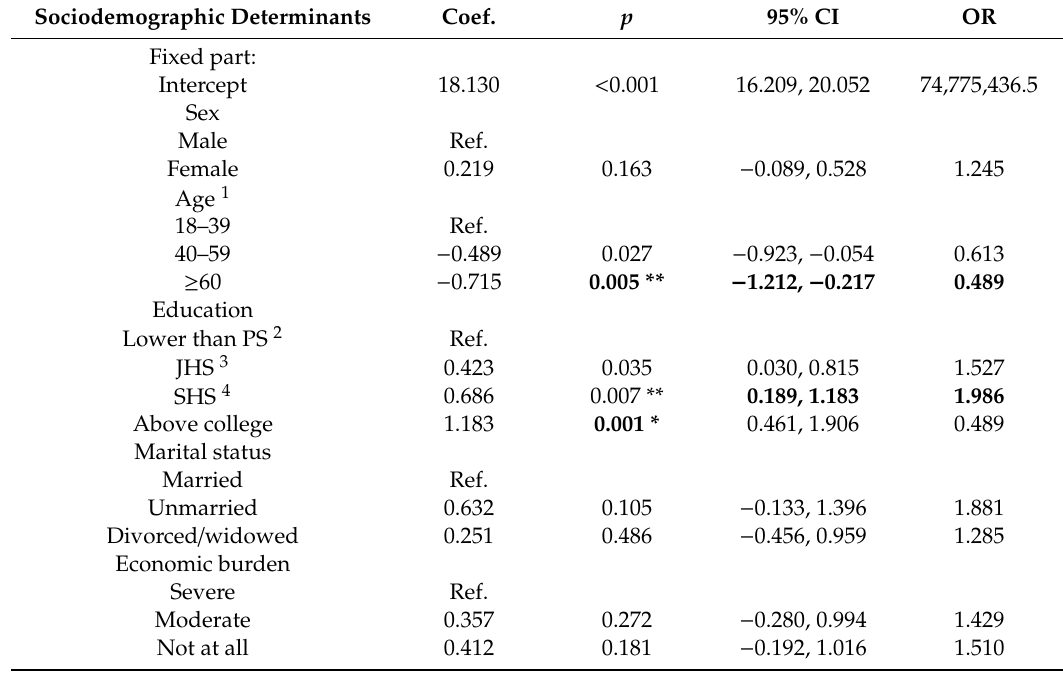
Table 4. Multilevel analysis of sociodemographic determinants of EOD ( n = 1290). Sociodemographic Determinants Coef. p 95%